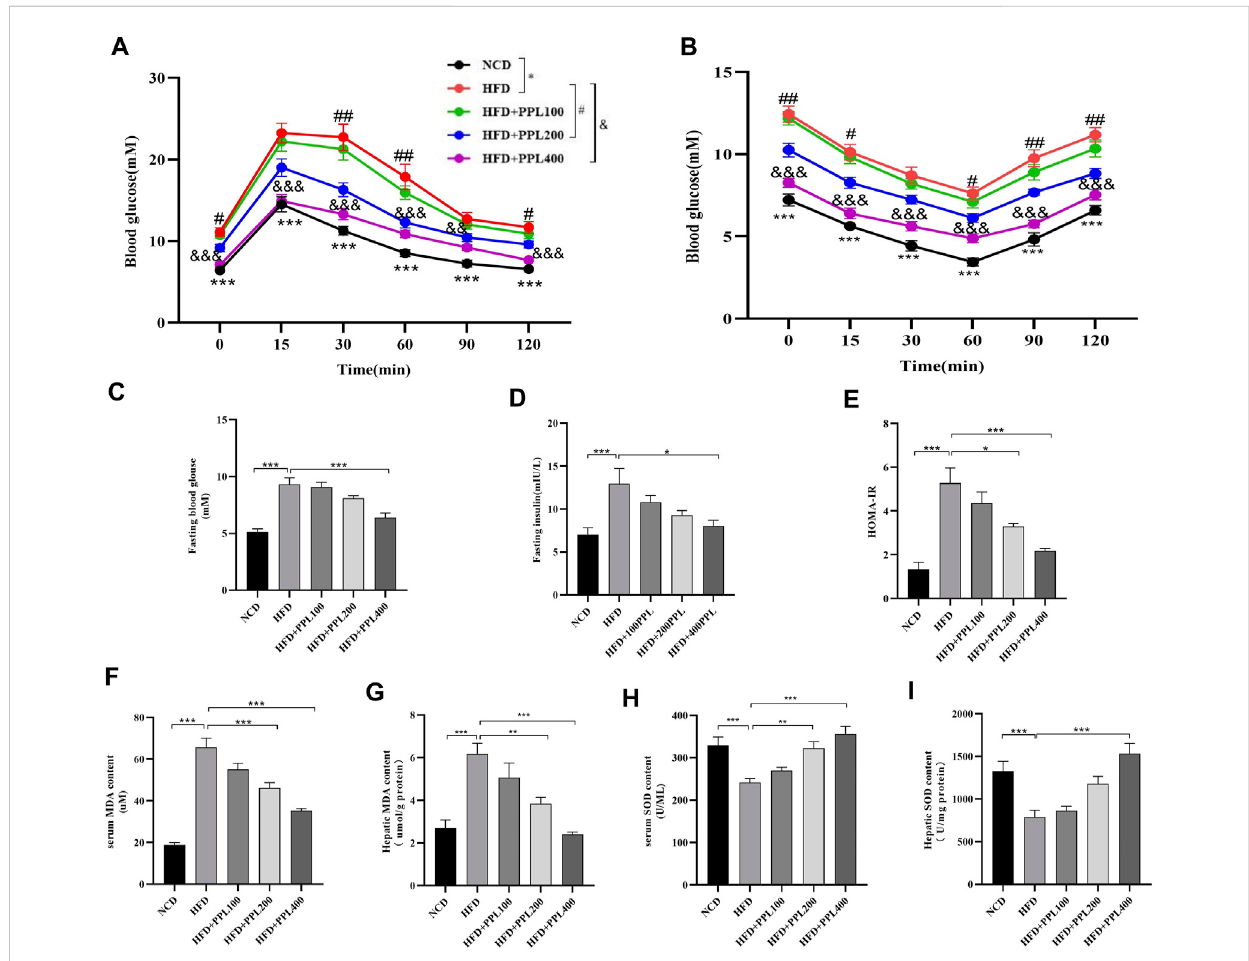
FIGURE 2 PPL improved glucose-lipid homeostasis and lipid peroxidation in HFD-induced obese mice. (A) Intraperitoneal injection glucose tolerance test (IPGTT). (B) Intraperitoneal injection insulin tolerance test (IPITT). (C) Fasting blood glucose. (D) Fasting insulin. (E) HOMA-IR indexes. (F,G) Serum and hepatic MDA content (n = 6-7 per group). (H,I) Serum and hepatic SOD content (n = 6-7 per group). Magni fi cation: ×200, scale bar: 100 μ m. Data were expressedasthemean±SEM.Differencesamonggroupswerecomparedbyone-wayANOVA.* p < 0.05,** p < 0.01,*** p < 0.001.# p < 0.05,## p < 0.01, ### p < 0.001. (n = 6-7 per